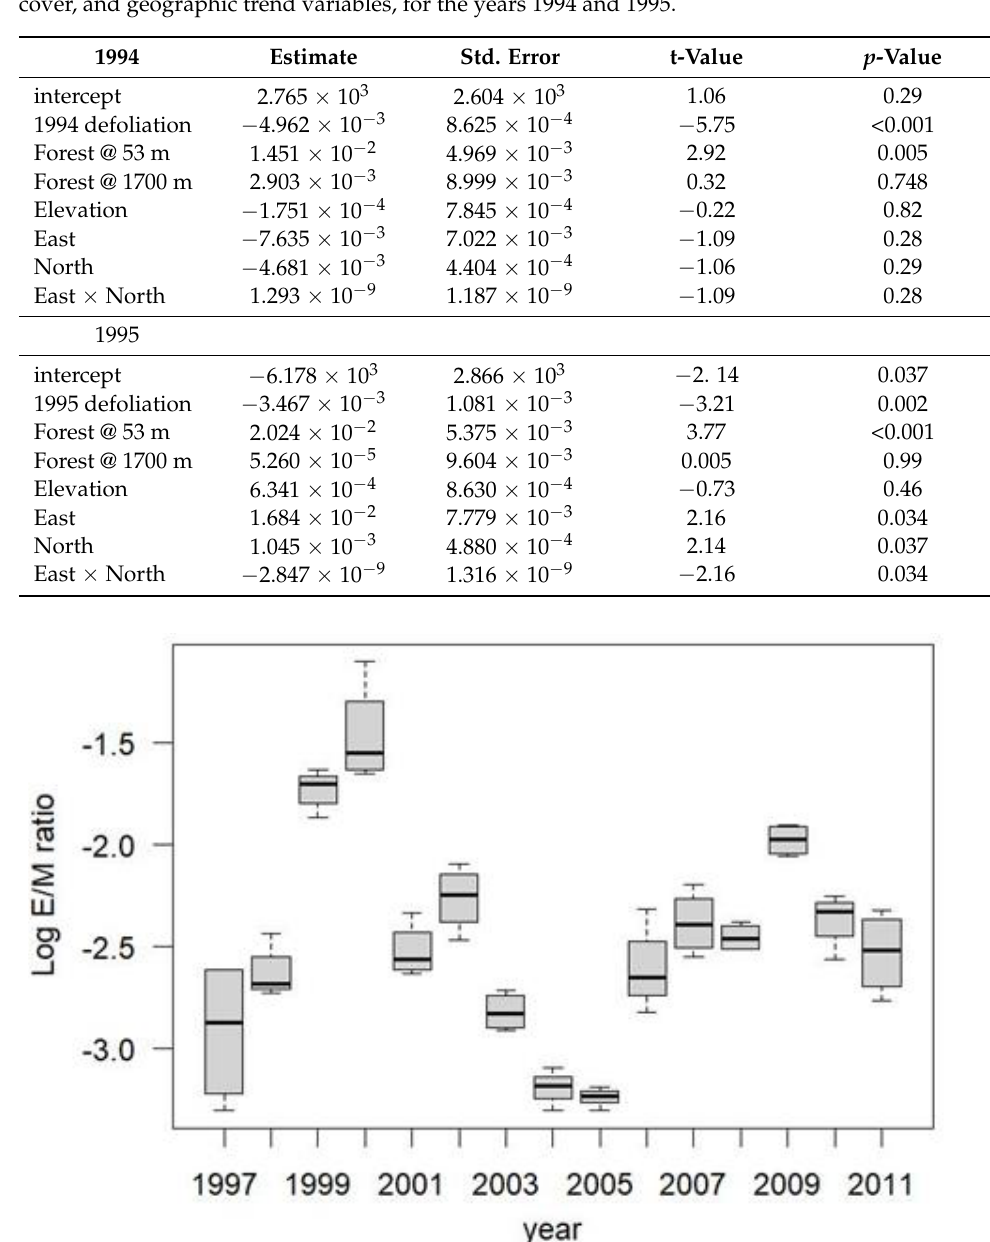
Figure 5. Zama spruce budworm Log 10 E/M ratios, 1997–2011. Years 1999, 2000, 2009 indicate anomalously high E/M ratios that may have been the result of mass immigration from outside the study area. (Log transformation was used to stabilize variances among